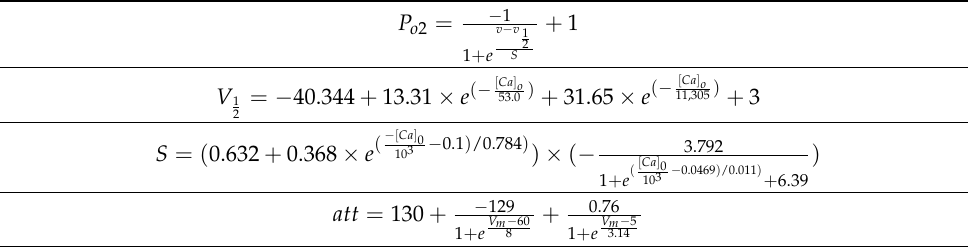
Table A1. Parameters for L-type Ca 2+ channel